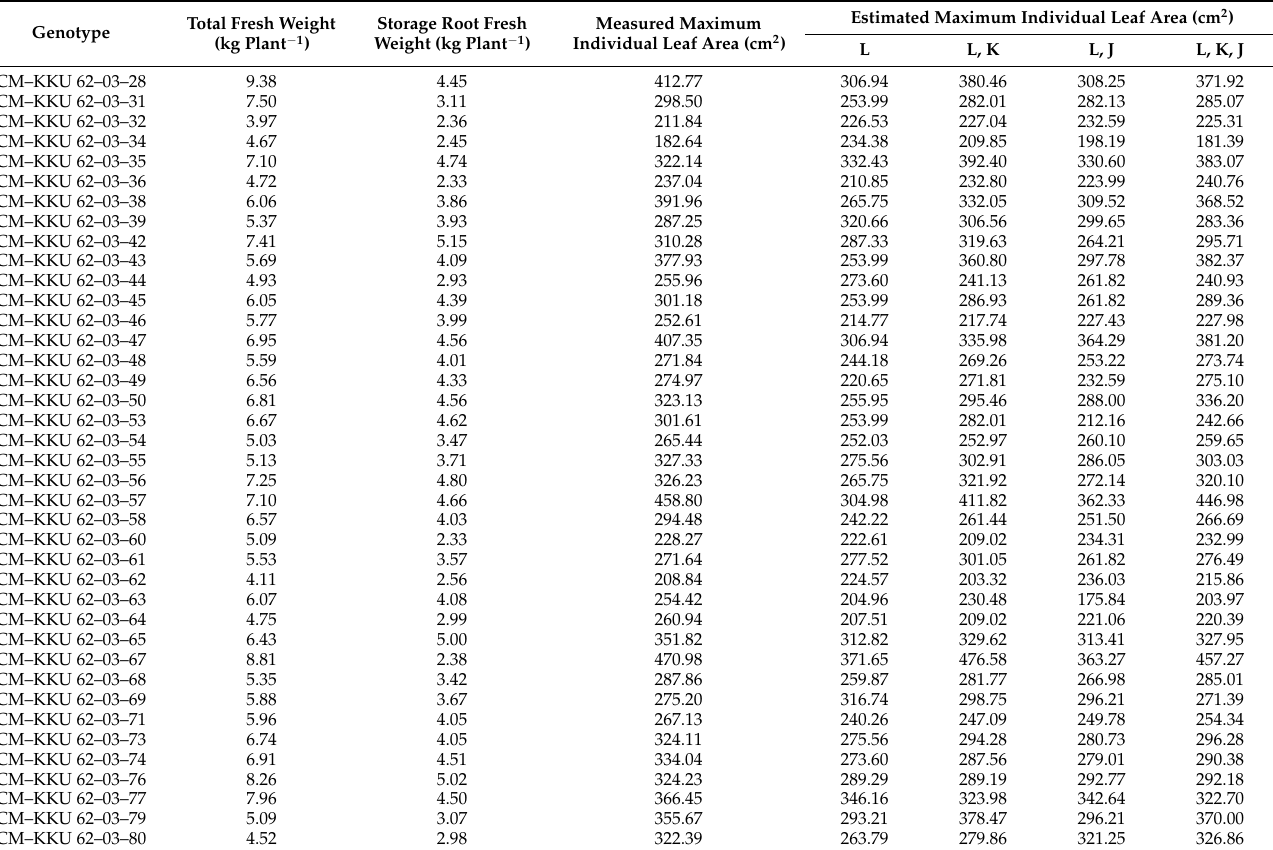
Table A2. Total fresh weight, storage root fresh weight, measured leaf area index (LAI), and estimated LAI. LAI based on the function of the length of the central lobe (L), the product of length and width (K), and the product of the length and number of lobes (J) together with the leaf numbers of the canopy for the Kasetsart 50 and CMR38–125–77 genotypes and 18 segregating progenies.